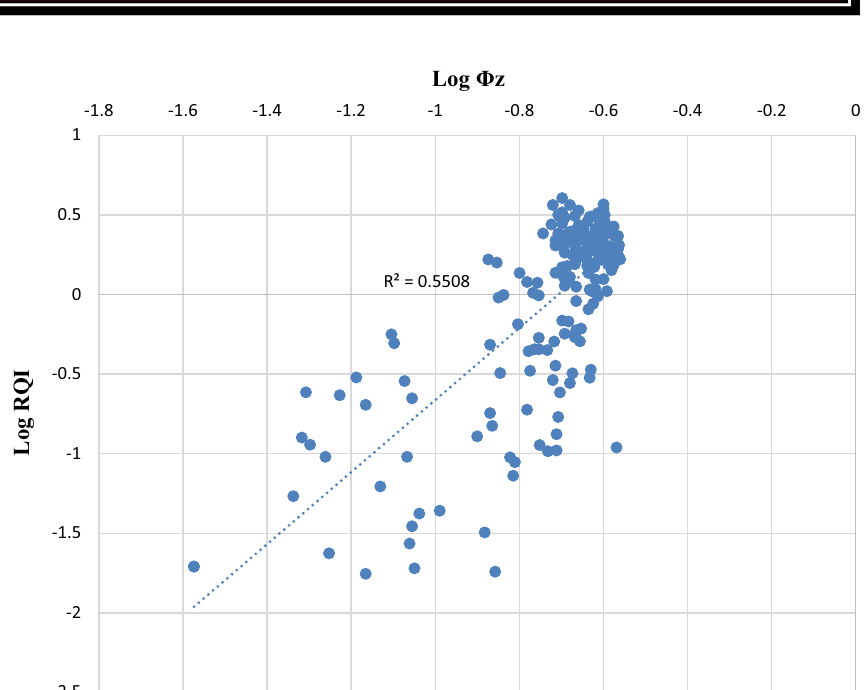
Figure 8 indicates the existence of four hydraulic flow units in the reservoir. Each unit is represented by a straight line with a unit slope and mean FZI value. This reflects that each unit is precipitated at certain geological conditions and has fluid flow properties different from the other unit.